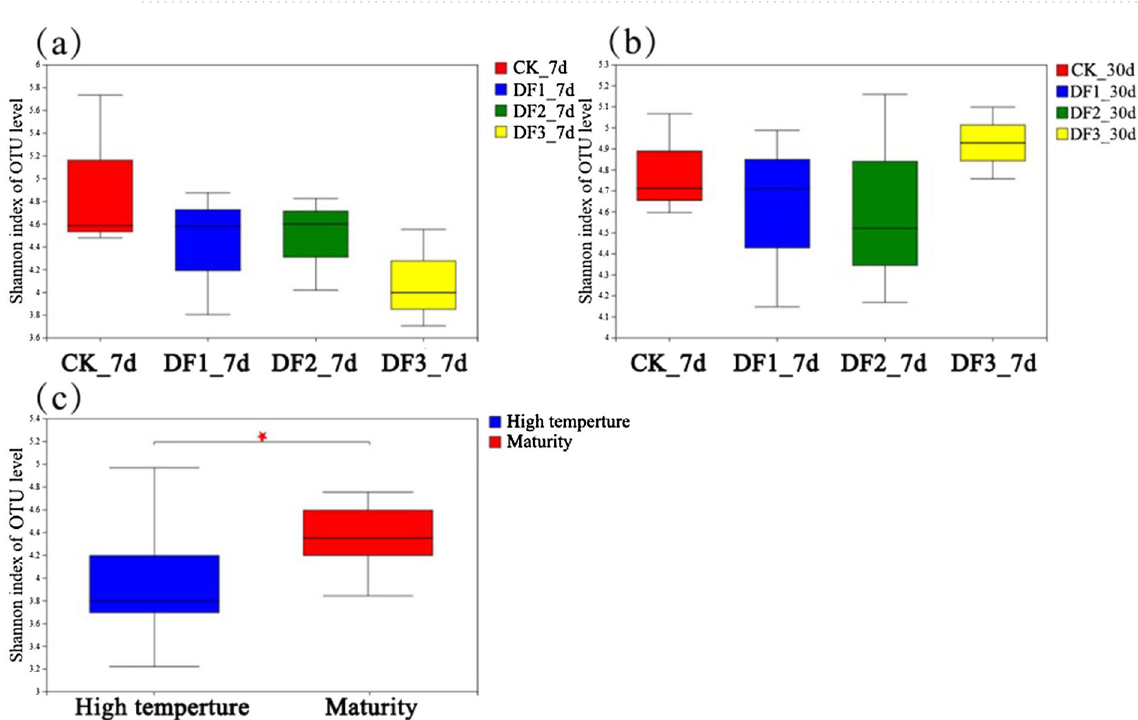
Figure 6. Shannon diversity index analysis. DF1_7d, DF2_7d, DF3_7d and CK_7d represent the samples on Day 7; DF1_30d, DF2_30d, DF3_30d and CK_30d represent samples on Day 30. High temperature and maturity represent high temperature and maturity stage, respectively. “*” represents p < 0.05 is a significant